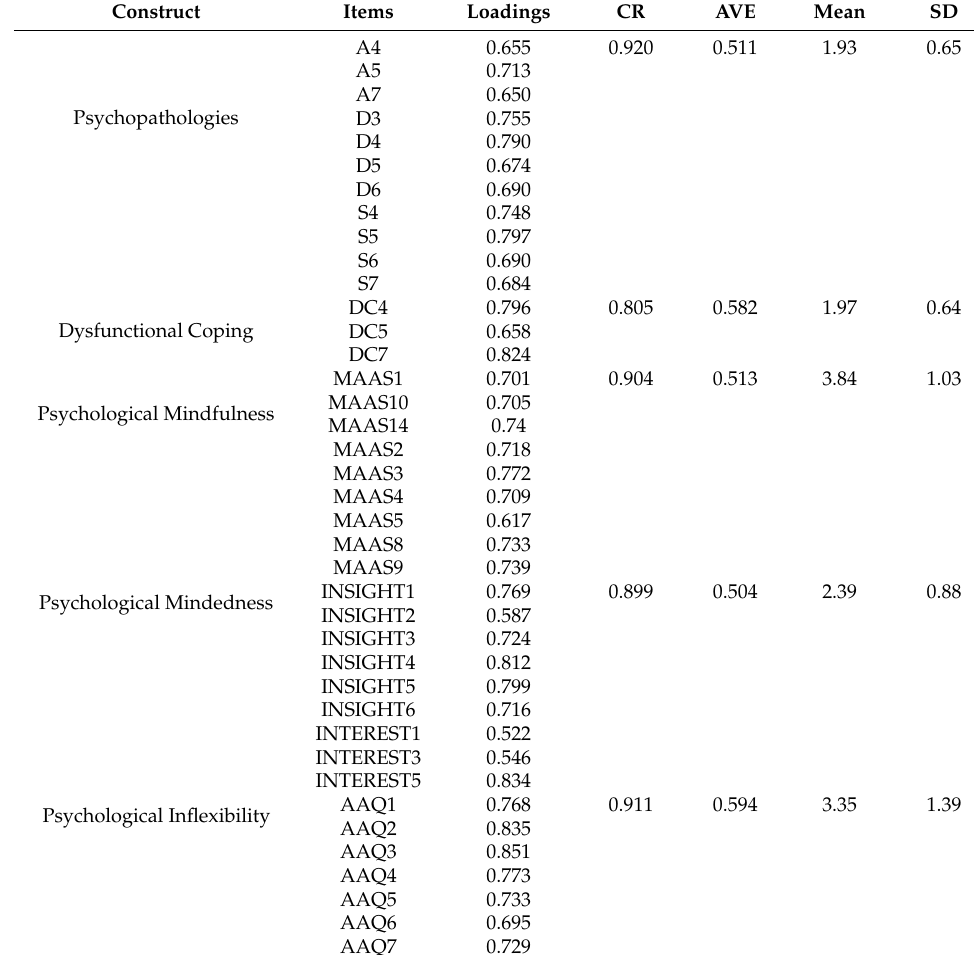
Table 1. Results of measurement model.